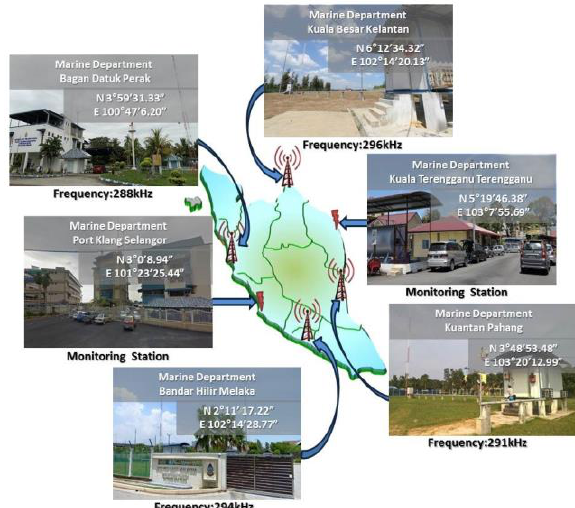
Figure 3. SISPELSAT Broadcasting and Monitoring Stations